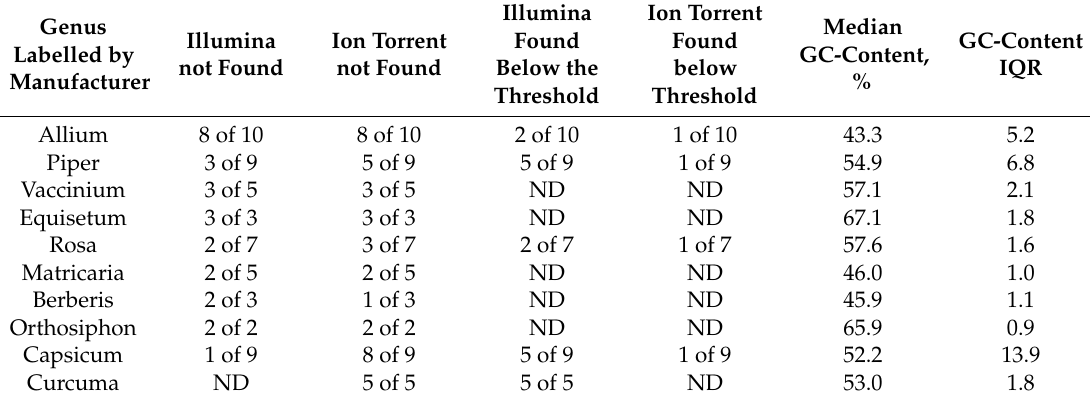
Table 1. Top10 plant components that were labelled but not found or found at a level below the